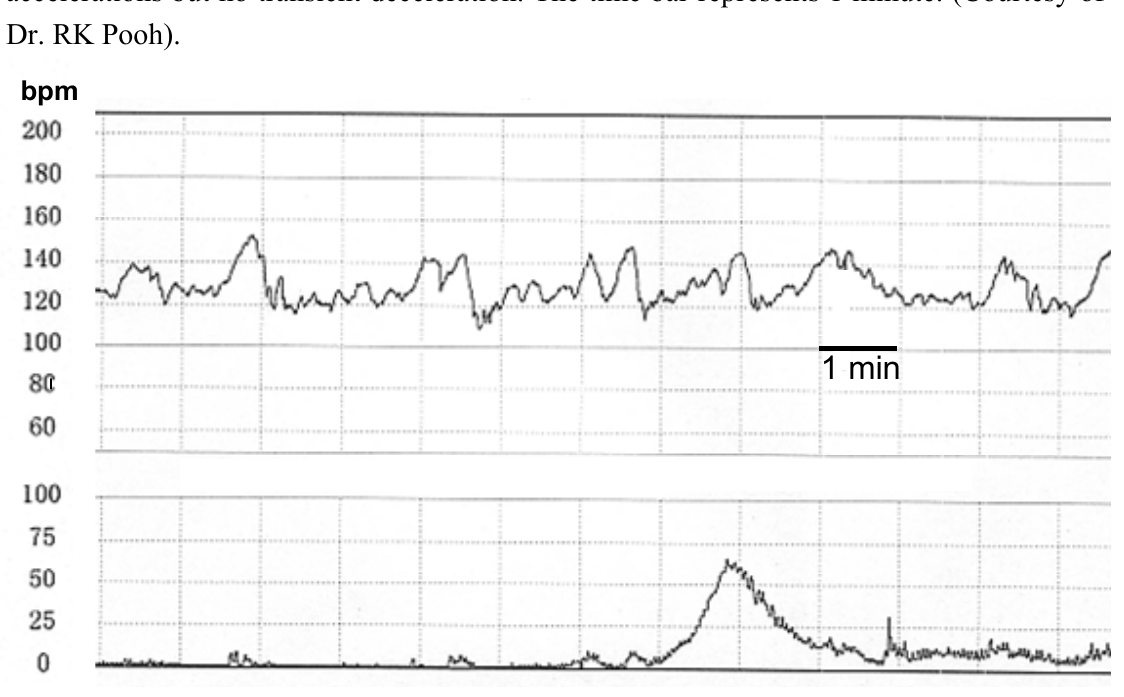
Figure 1. The cardiotocogram (CTG) recorded during the labor. Fetal heart rate (FHR) is traced in the upper channel and uterine contraction in the lower one. The CTG is normal and reassuring because of normal baseline level, normal baseline variability, transient FHR accelerations but no transient deceleration. The time bar represents 1 minute. (Courtesy of Dr. RK